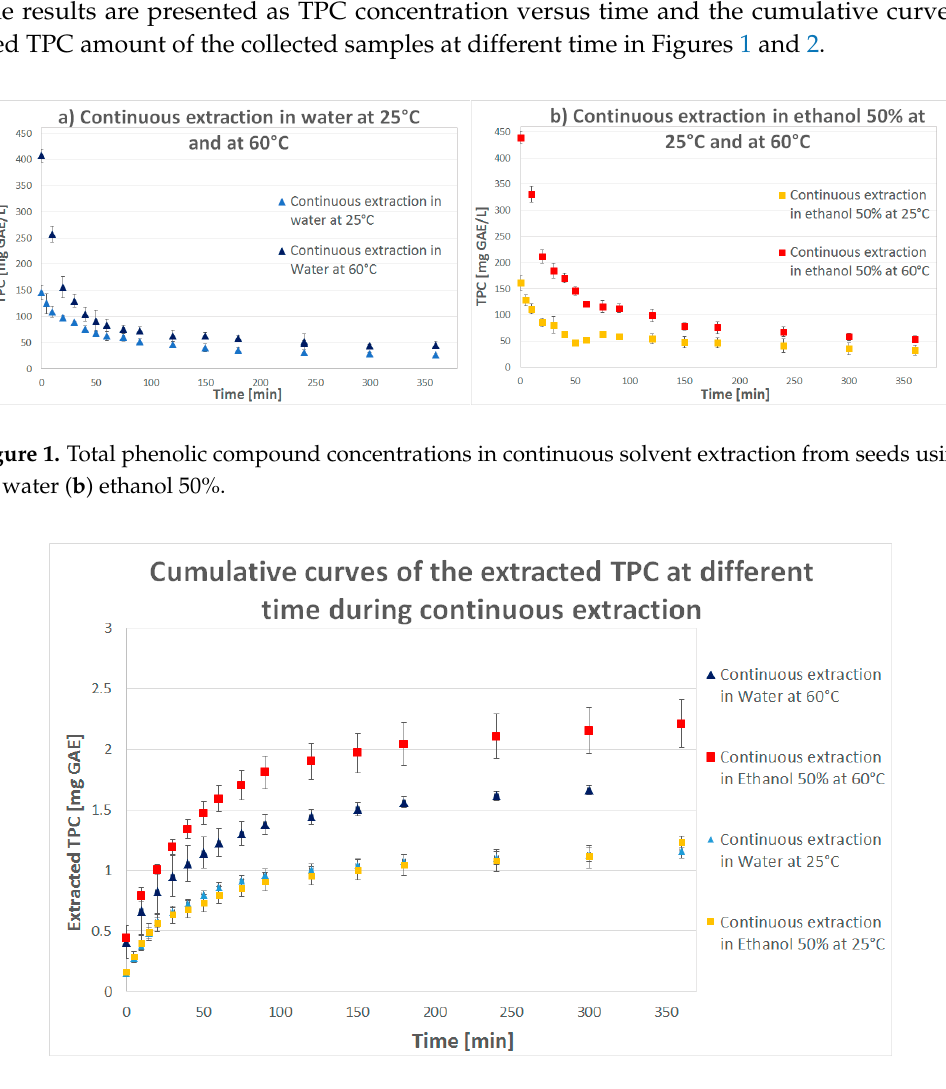
Figure 2. Cumulative curve of the extracted Total Phenolic Content (TPC) at different time during the continuous solid-liquid extraction.